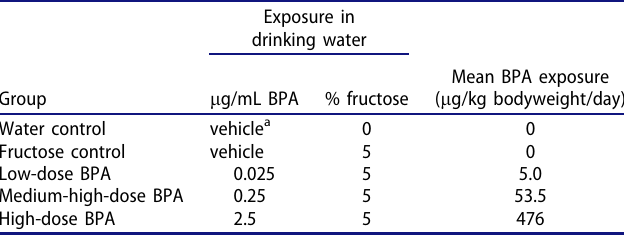
Table 1. Exposure of rats to BPA from 5 to 15 weeks of